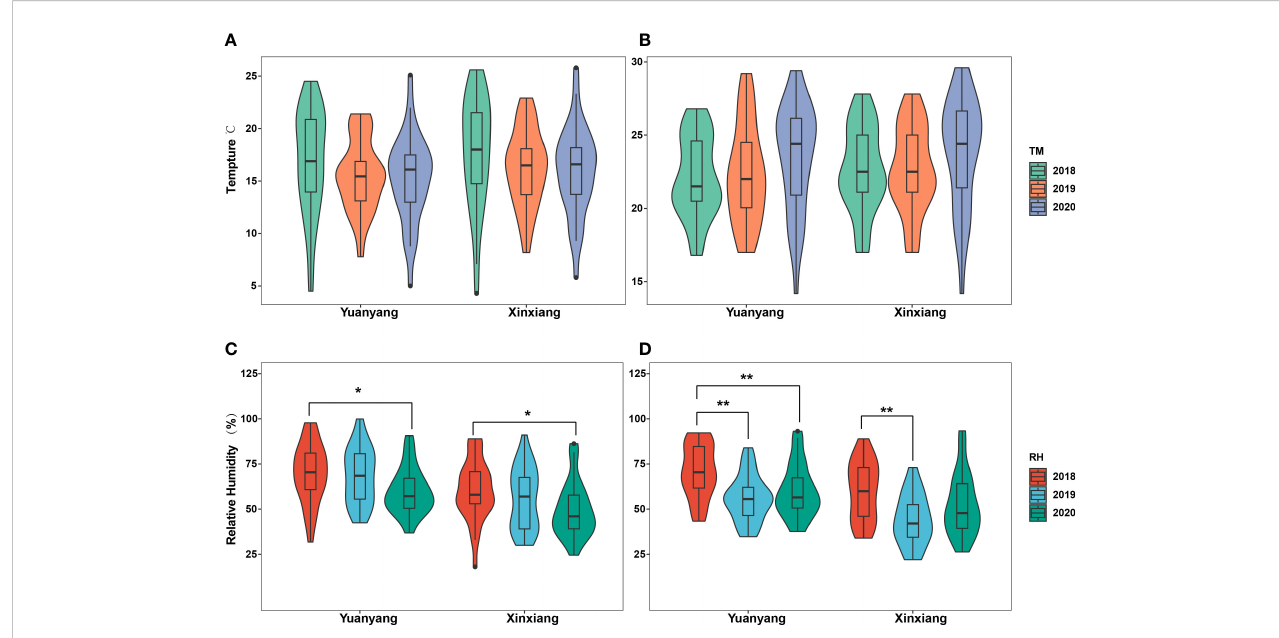
FIGURE 2 Statistical analysis of temperature and relative humidity among years in Yuanyang and Xinxiang regions. (A, B) Analysis with the April and May temperature obtained in Yuanyang and Xinxiang regions, respectively. (C, D) Analysis with the April and May relative humidity in Yuanyang and Xinxiang regions, respectively. *, indicating signi fi cant (p<0.05); **, indicating very signi fi cant